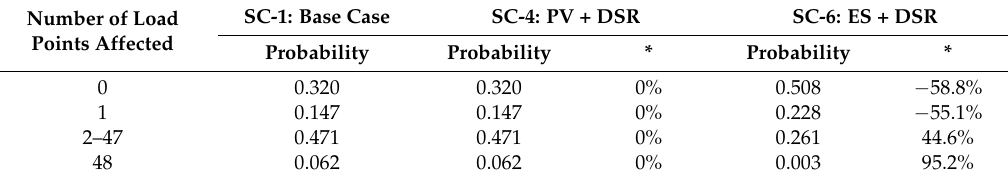
Table 4. Probability of the number of load points affected by supply